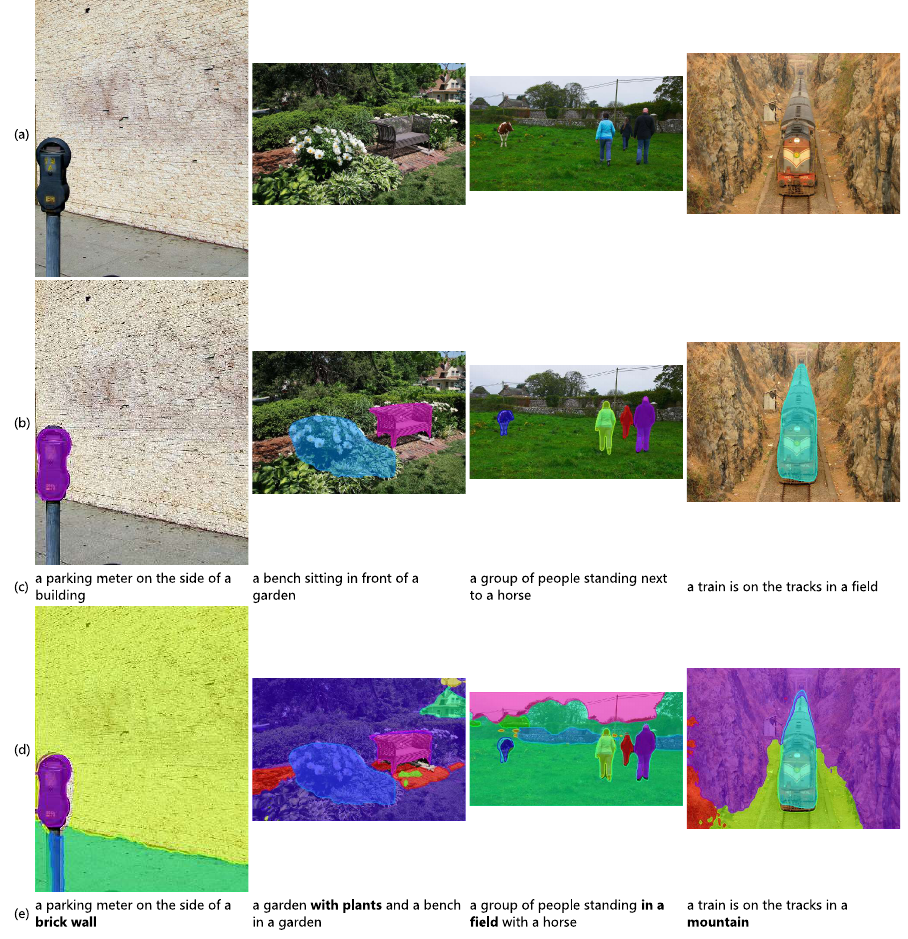
Figure 8. Examples of captions and the attention regions of InstanceSegAtt and